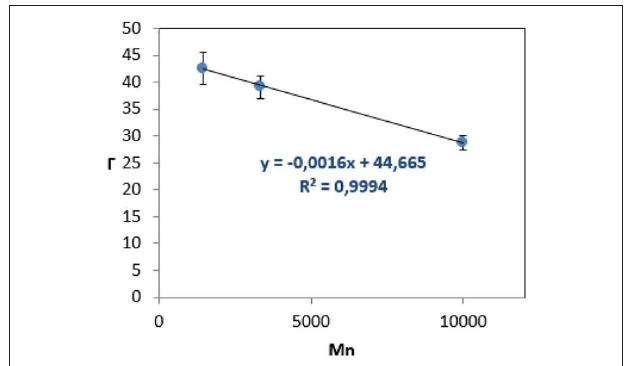
FIGURE 9 | Ŵ obtained from the HDT fit for Ca > 2 · 10 − 3 vs. Mn .